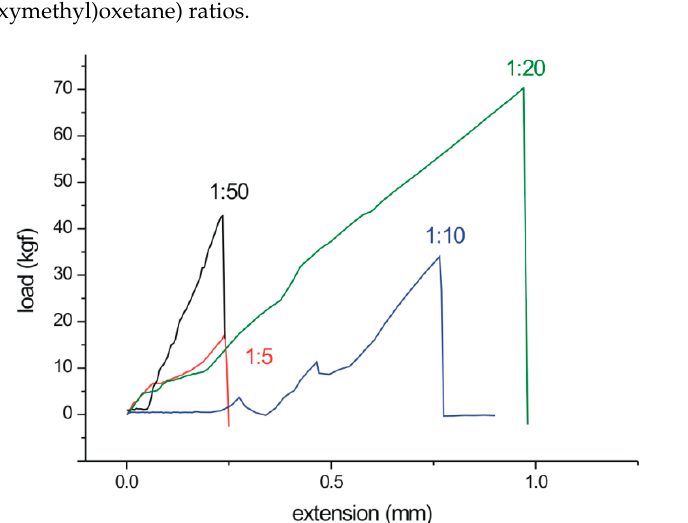
Figure 8. Figure 8.